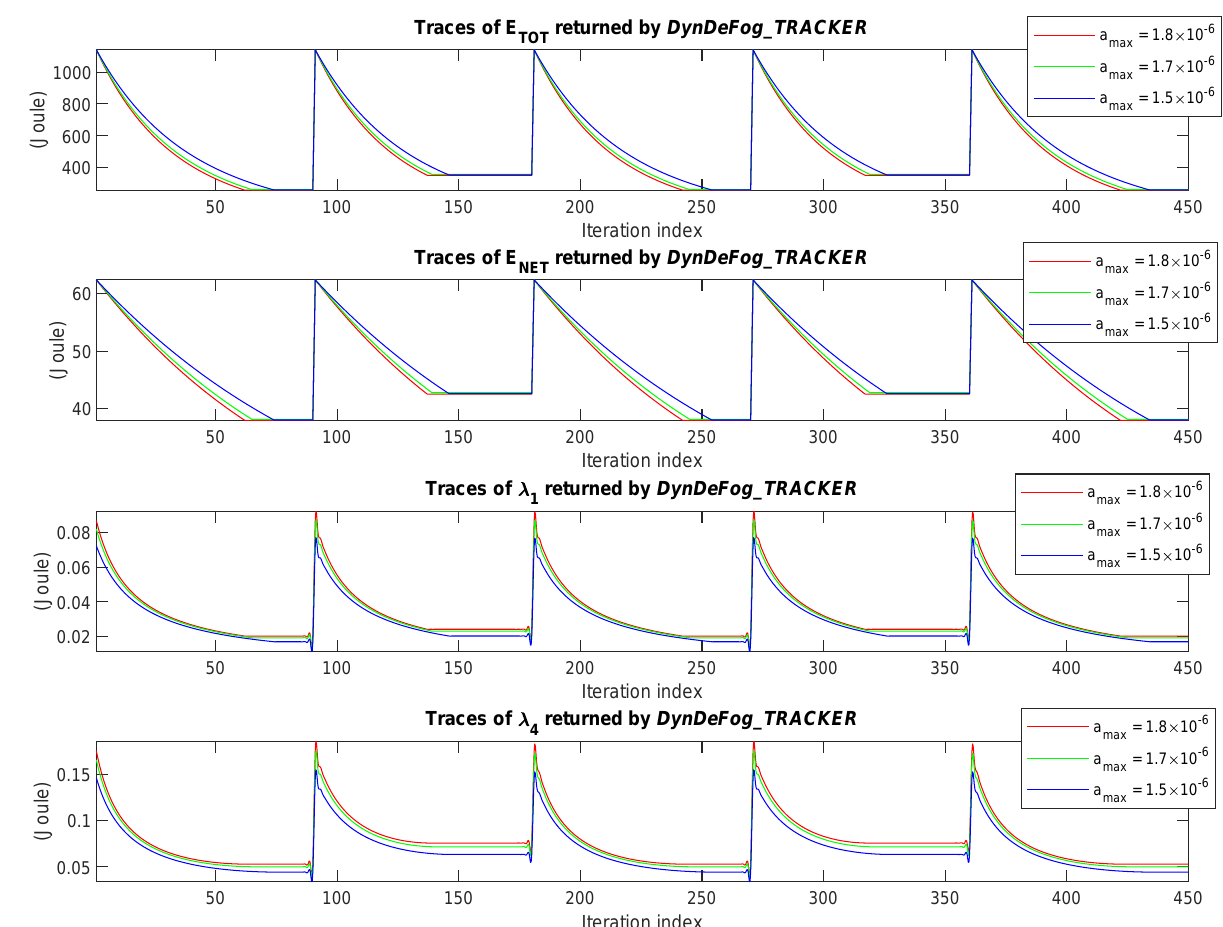
Figure 15. Tracking performance of DynDeFog_TRACKER under the sequential failure of nodes Fog ( 1,3 ) and Fog ( 2,3 ) of topology T